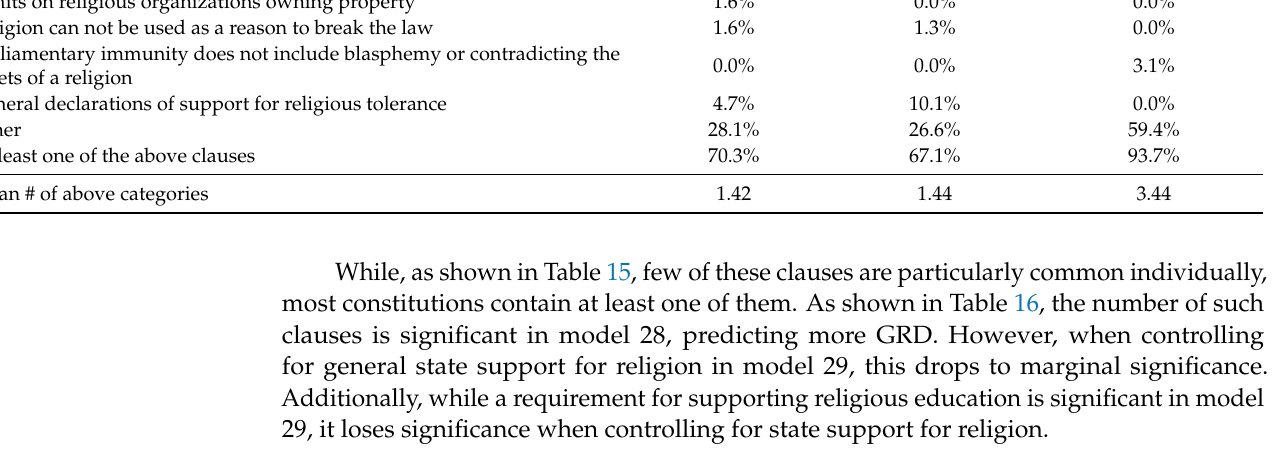
Table 16. OLS regressions predicting the influence of other types of religion clauses on GRD and final model in